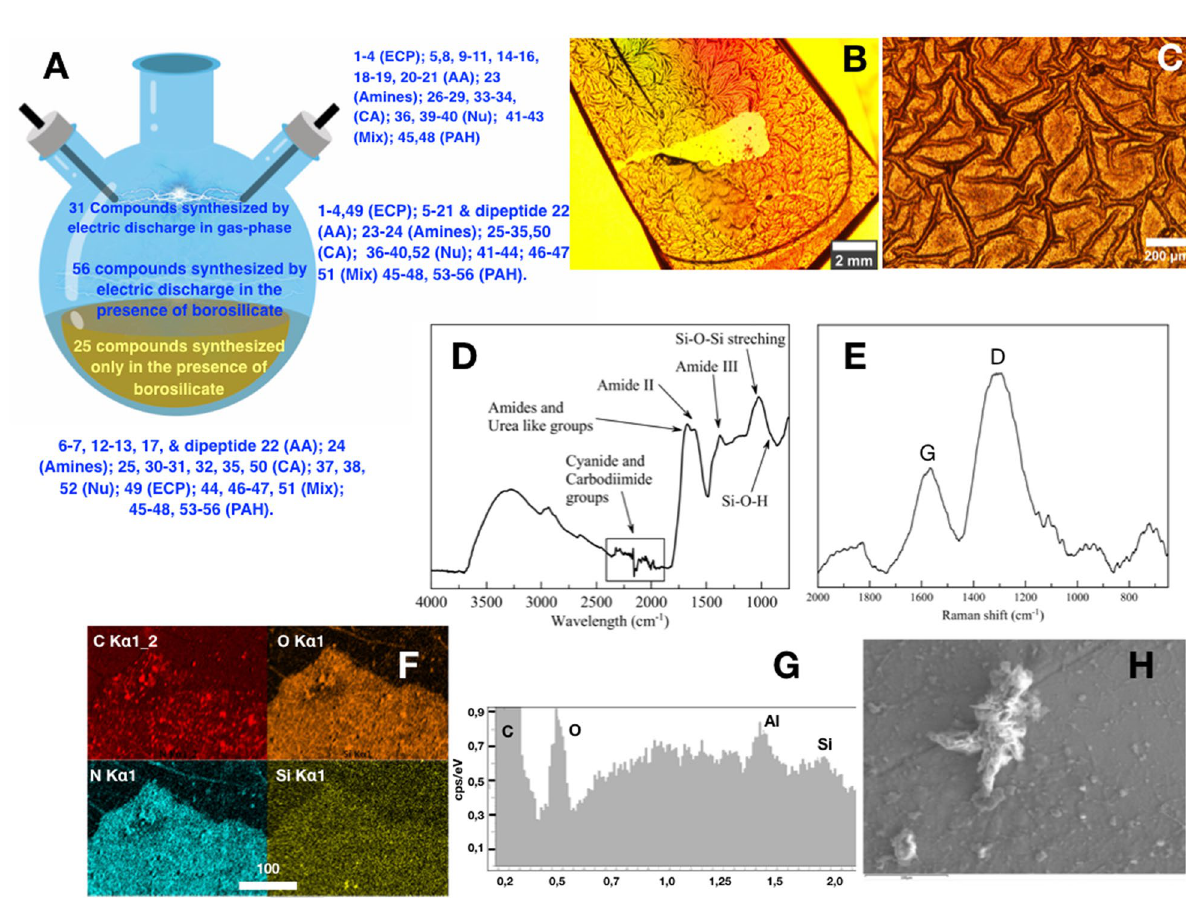
Figure 3. Reaction products obtained in the experiments. (A) Comparison of molecular diversity among the three experiments. Note that amino acids, carboxylic acids, and nucleobases were always produced in the presence of borosilicate in total percentage higher than other products (C-1 chemical precursors and amines), thus favoring the mass balance towards the formation of compounds that are, in principle, useful intermediates for molecular evolution. (B,C) Optical micrographs of the wet (B) and dry (C) organic film covering the inner wall of the borosilicate flask; (D) infrared spectra of the organic skin; (E) Raman spectra of the organic skin after carbonation, showing D and G peaks. (F) EDX mapping of the organic film; (G) EDX elemental composition of the particle shown in (H) showing the existence of silicon in the